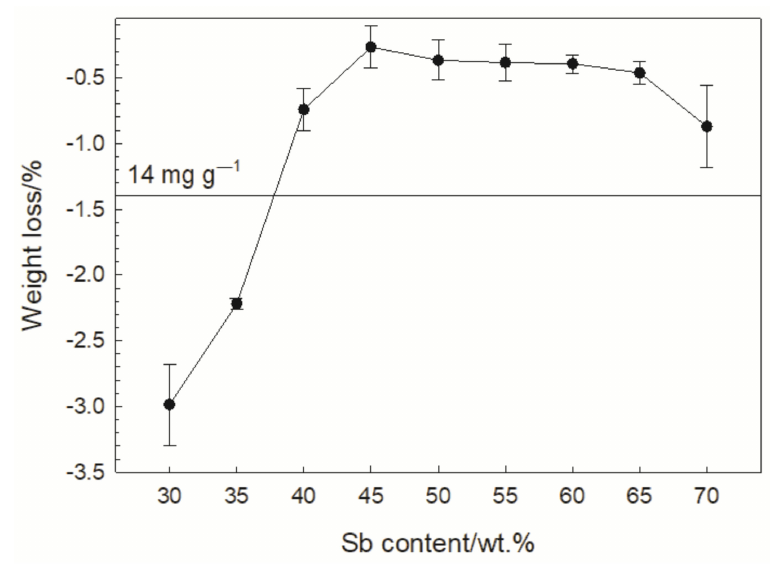
Figure 9. Percentage mass loss of Sb/KMnO 4 samples burned in an argon atmosphere.